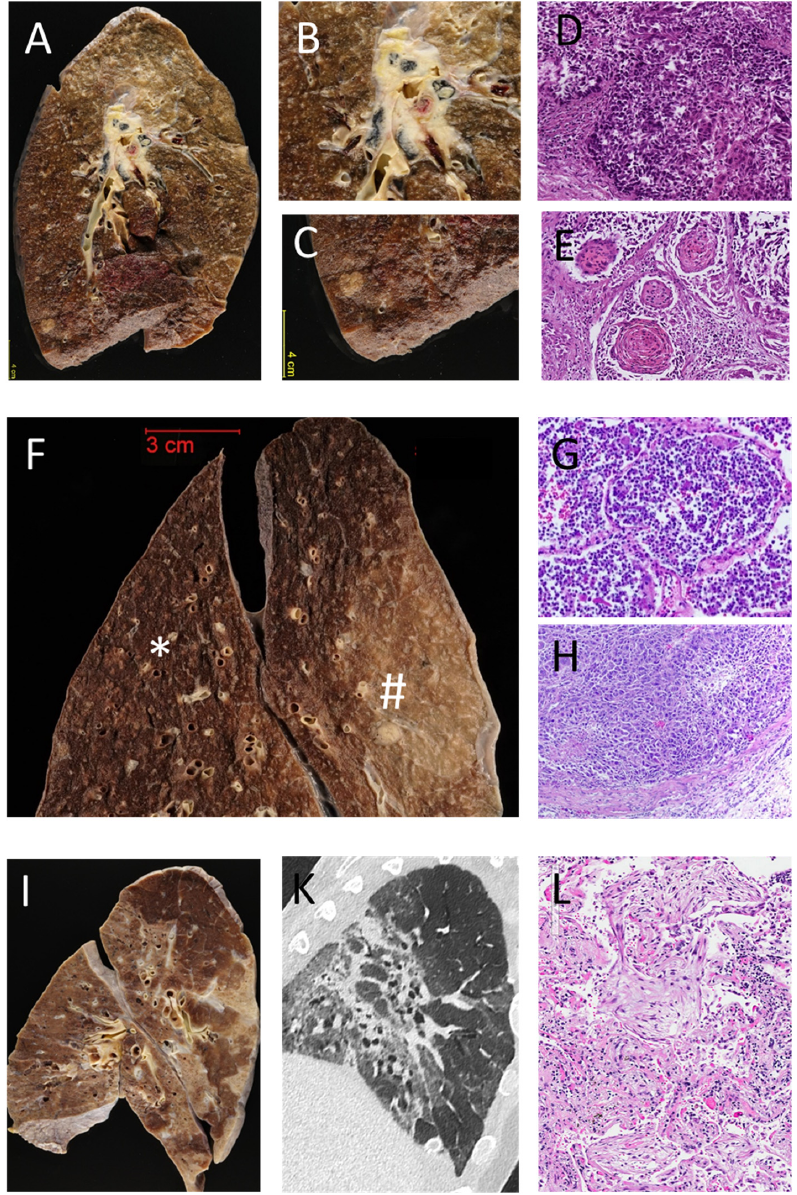
Figure 1. Illustrative examples of postmortem findings in the lungs: ( A – E ) Case 1: Clinical Diagnosis: pulmonary bleeding, most probably due to a central lung cancer. ( A ) Large transversal section shows a large bronchial carcinoma, centrally located with infiltration and with arrosion of large vessels and bronchi ( A , B ). Additionally, in the lower lobe, a second tumor was identified ( A , C ). Histologically, the central tumor was a poorly differentiated squamous cell carcinoma ( D ). The tumor in the lower lobe ( E ) was a well differentiated squamous cell carcinoma, due to the different morphology considered to be a second, independent malignancy. ( F – H ) Case 2: Clinical Diagnosis: diffuse metastasizing melanoma. F: multiple, partially inhomogeneous (*), partially well circumscribed (#) nodules and indurations in the lungs. Histological coexistence of acute bronchopneumonia ( G , corresponding to *) and multiple intravascular infiltrations of melanoma ( H , corresponding to #). No parenchymatous metastases were detected. ( I – L ) Case 3: Clinical Diagnosis: unclear pulmonary fibrosis. ( I ): Patchy consolidations in all lobes. ( K ) Corresponding CT scan. Histology showed organizing pneumonia ( L ). All histological stains are Hematoxylin/ and Eosin; original magnification 20 ×